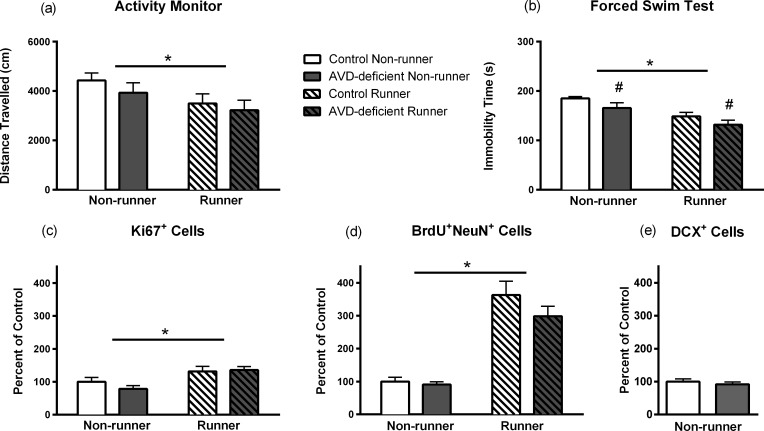
Results for the activity monitor, forced swim test (FST), and Ki67+, BrdU+ NeuN+, and DCX+ cell counts.The distance travelled in the activity monitors is shown in (a) (n = 13–15 per group). There was no significant effect of Diet but there was a significant main effect of Running. Runners moved less than Non-runners. Immobility time during the FST is shown in (b) (n = 7–8 per group). There was a main effect of both Diet and Running. Wheel running significantly reduced immobility time; moreover AVD deficiency also reduced immobility time. The number of Ki67+ is shown expressed as a percent of control non-runner values (c) (n = 8 per group). There was no significant effect of diet but there was a significant effect of Running. Runners had higher numbers of Ki67+ cells compared to Non-runners. There was no significant difference between control and AVD-deficient mice. BrdU+ NeuN+ cell counts expressed as a percent of control non-runner values is shown in (d) (n = 8 per group). There was a significant increase in the number of BrdU+ NeuN+ cells following voluntary running. However, there was no significant effect of Diet on baseline cell numbers or cell numbers stimulated by voluntary running. The number of DCX expressed as a percent of control non-runner values is shown in (e) (n = 7 per group). Where main effect is significant, p-value is given on graph. Mean ± SEM (* p < 0.05).